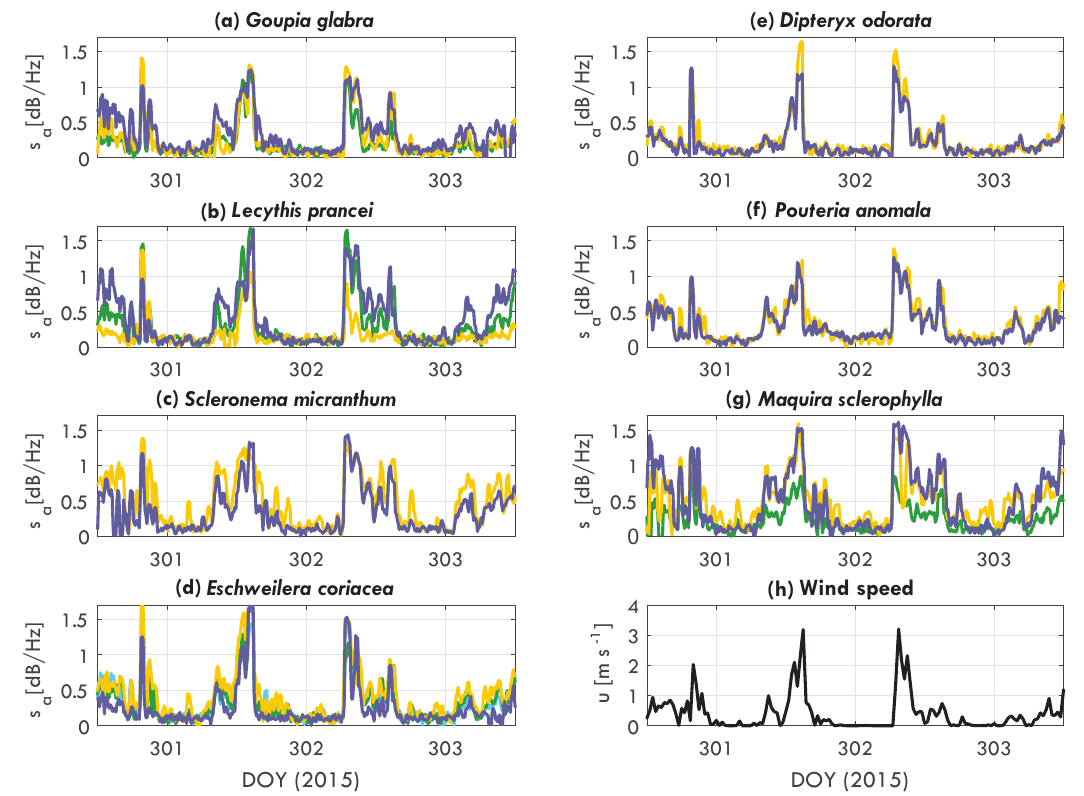
Figure 3. Tree acceleration spectra slope s a [dBHz − 1 ] over time for DOY 301 to 306 (2015), for (a) Goupia glabra , (b) Lecythis prancei , (c) Scleronema micranthum , (d) Eschweilera coriacea , (e) Dipteryx odorata , (f) Pouteria anomala , (g) Maquira sclerophylla , and (h) wind. Each line in (a–g) represents an individual